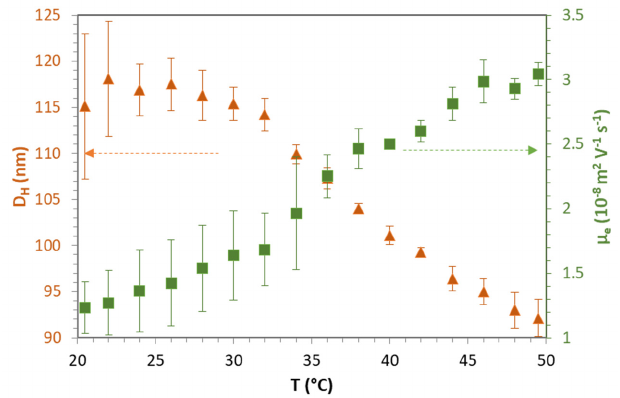
Figure 2. Hydrodynamic diameter (orange triangles) and electrophoretic mobility (green squares) of mGel+ in ultrapure water, as a function of temperature. Values plotted are mean of three independent measurements with standard deviation.